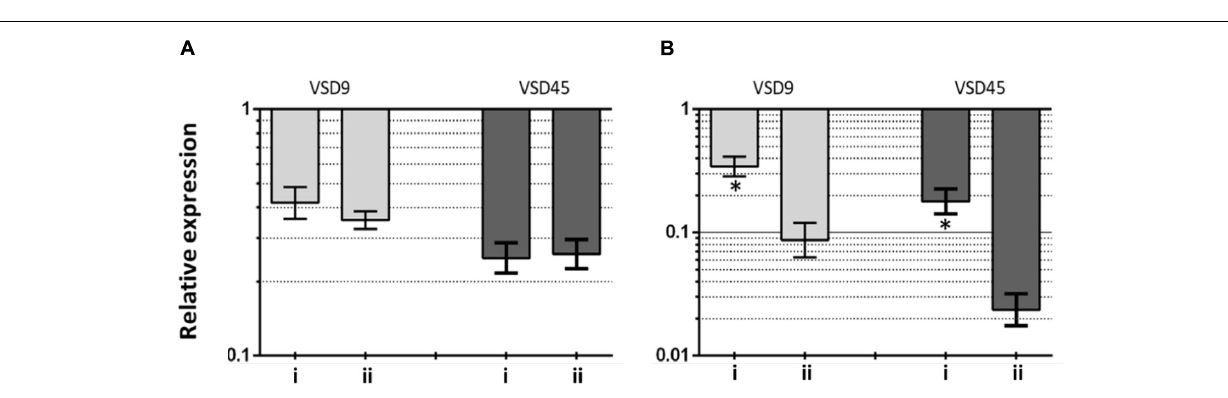
FIGURE 5 | Transcriptional profiling of (A) brpA -like (encoding biofilm regulatory protein) and (B) fbpA (fibronectin-binding protein A) in the SDSD strains AuAgNPs combined with visible light irradiation (VLI) relative to the untreated. 16S rRNA gene was used as the internal control for normalization. Relative expression was calculated by the 2 − (cid:49)(cid:49) Ct method. (i) AuAgNP and (ii) AuAgNP and VLI. Nanoparticles were at 10 nM and VLI at 2.02 W cm − 2